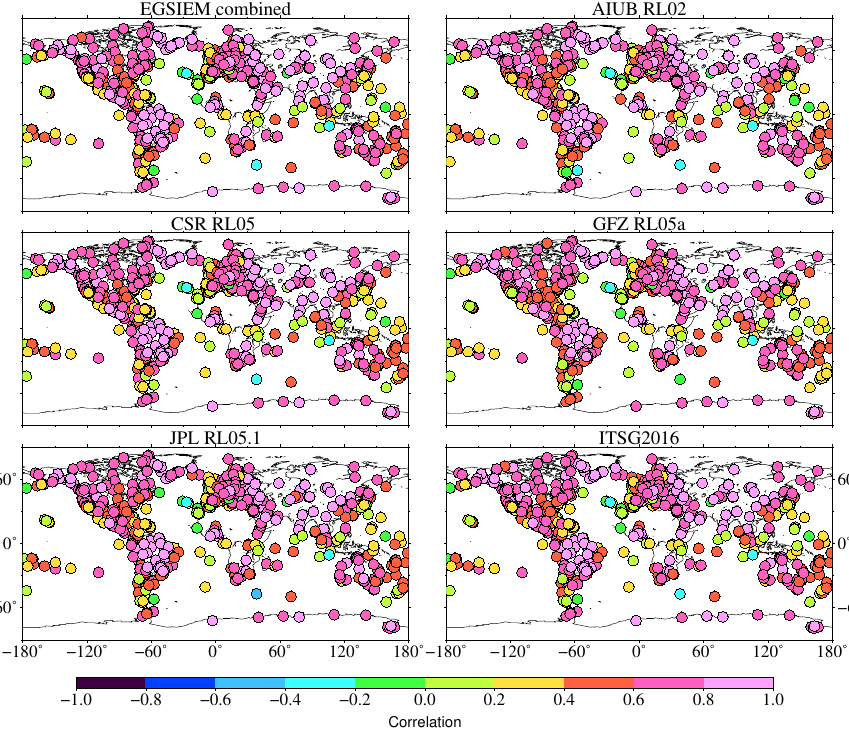
Figure 2. Correlations between GNSS-observed and Gravity Recovery and Climate Experiment (GRACE)-derived displacements over 928 GNSS stations using the ITRF2014